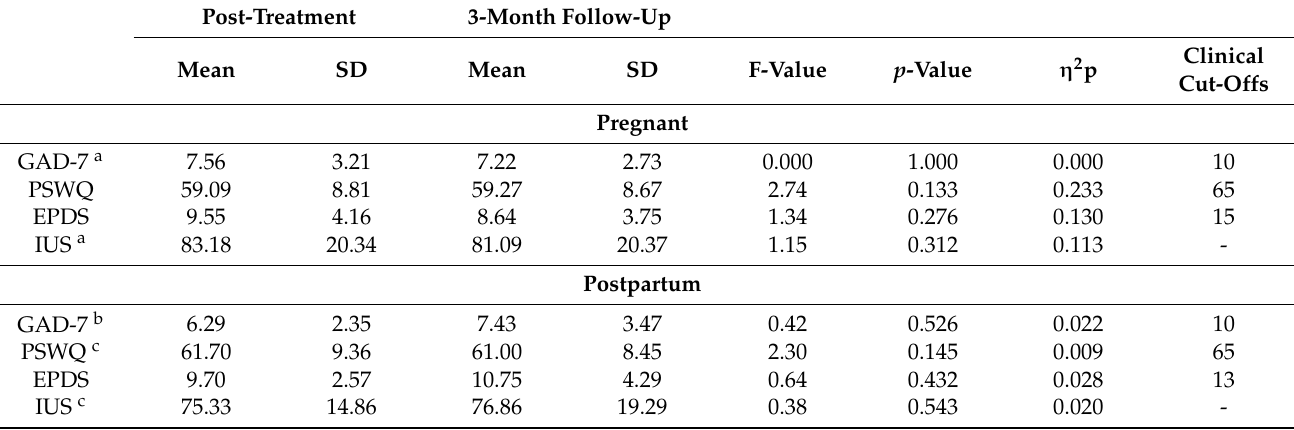
Table 4. Post-Treatment to Follow-up Symptom Change in Pregnant ( n = 11) and Postpartum ( n = 24)